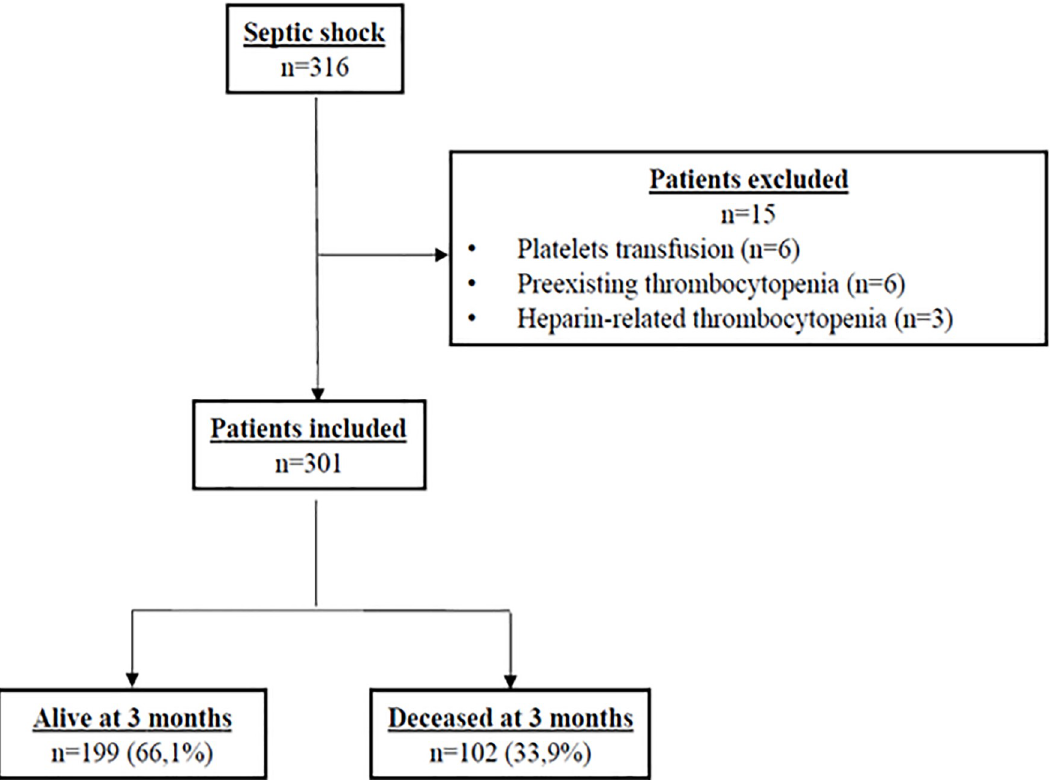
Fig 1. Flowchart of the enrolment of the patients in the study.